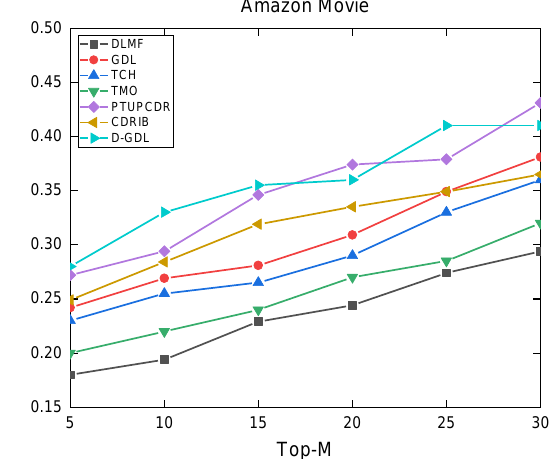
Figure A9. Performance comparison of D-GDL for different values of a based on recall for the Amazon books and movies datasets.